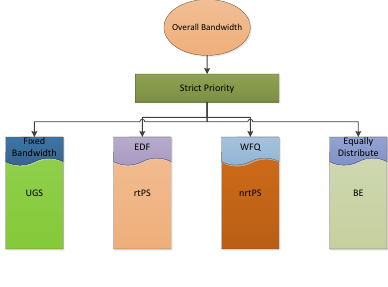
Figure 4. Hierarchical